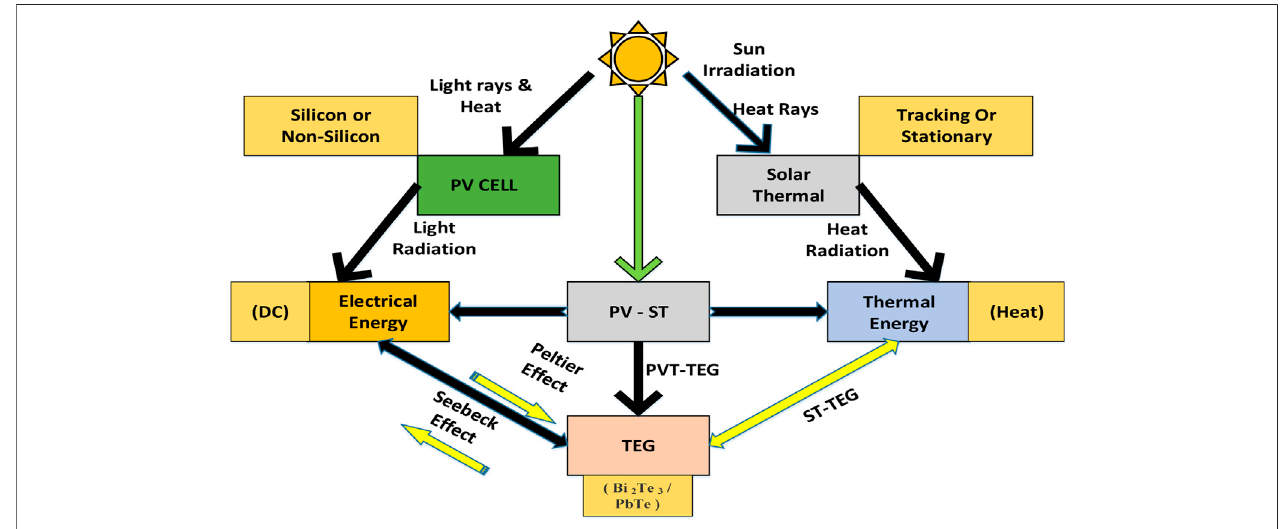
FIGURE 10 | perational structure of PV-ST-TEG.